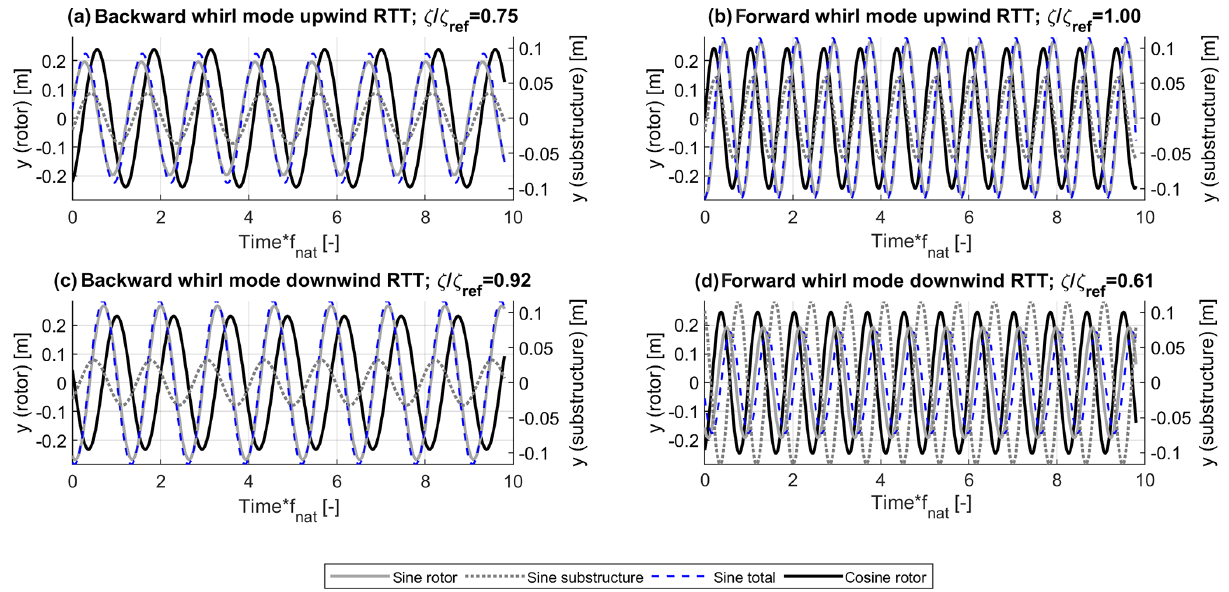
Figure 5. Modal out-of-plane displacements at 9ms − 1 for the backward whirl mode (a, c) and forward whirl mode (b, d) of the upwind RTT (a, b) and downwind RTT configuration (c, d) . The time axis is normalized with the blade edgewise natural